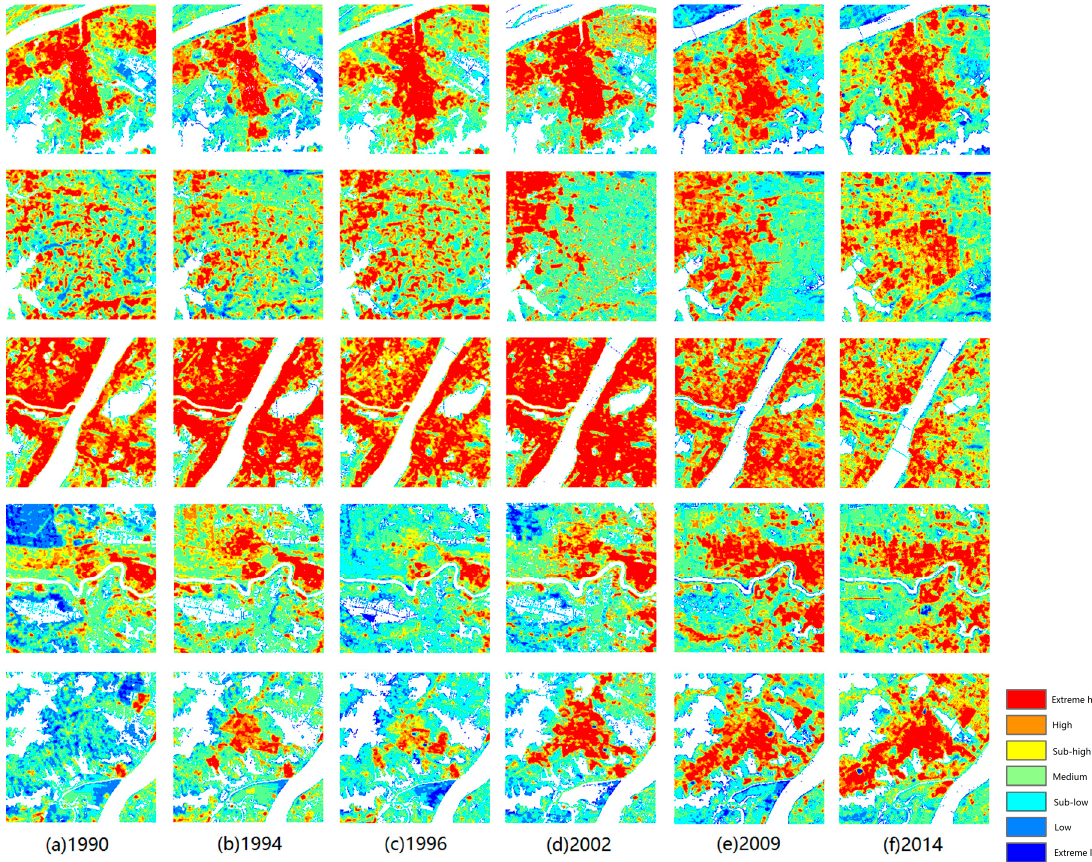
Figure 6. Surface urban heat island (SUHI) evolution (from top to bottom, circle 1 to circle 5; from left to right, the years 1990 to 2014).